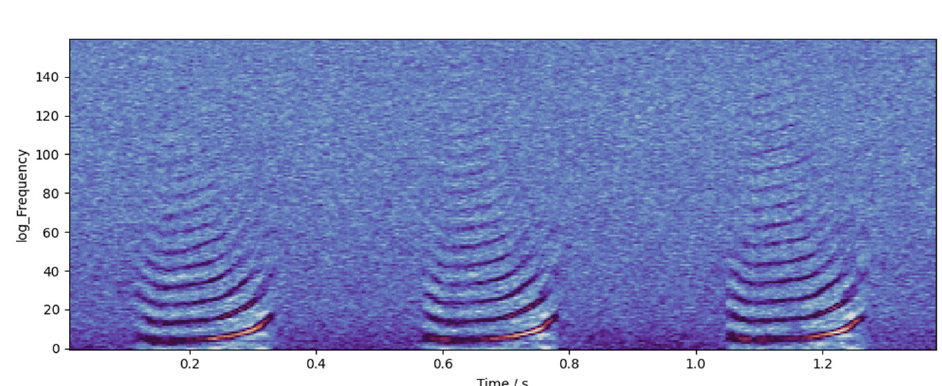
Figure 10. An example of cepstrogram. The highlighted part in the figure is the high-energy point of the sound in the time–frequency domain. After the logarithmic calculation, the fundamental frequency and formant of the sound are more prominent, which is conducive to observation and recognition.